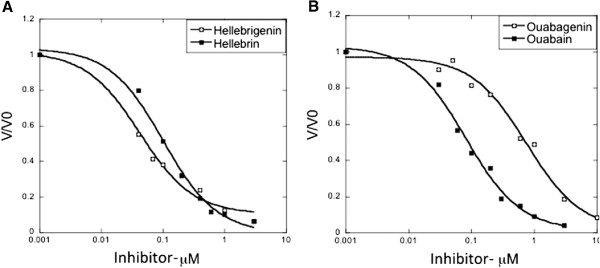
Inhibition of purified human α1β1 Na+/K+-ATPase by the glycoside (closed circles) and aglycone (open circles) pairs of A: hellebrin/hellebrigenin and B: ouabain/ouabaigenin. (panel B) Solid lines are the fitted curves for a one site fitted model (see Materials and Methods).The curves represent the averages of two experiments in duplicates.